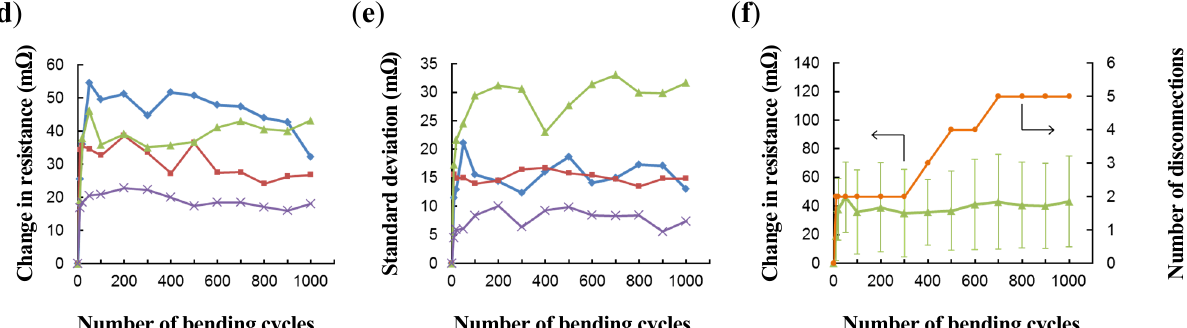
Figure 15. Change in resistance during the bending test for a curvature radius of 5 mm: ( a – c ) continuous measurements; ( d – f ) intermittent measurements; and ( c , f ) concave bending about the Y -axis.